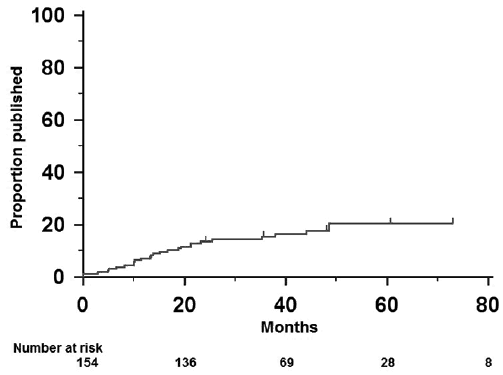
Figure 1 - Time to publication of Brazilian studies initially presented in abstract form between 2001 and 2005 (tick marks represent censoring)